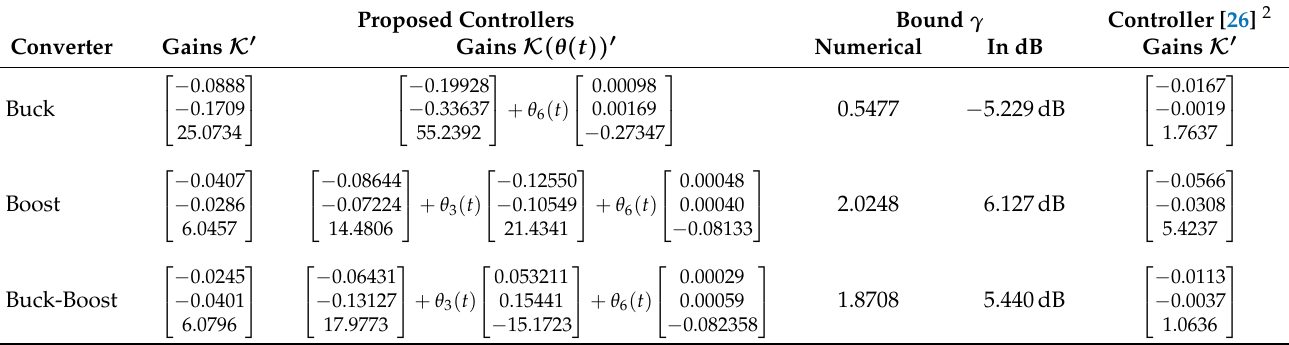
Table 2. Controllers 1 synthesized with the proposed approach and the method from [26].